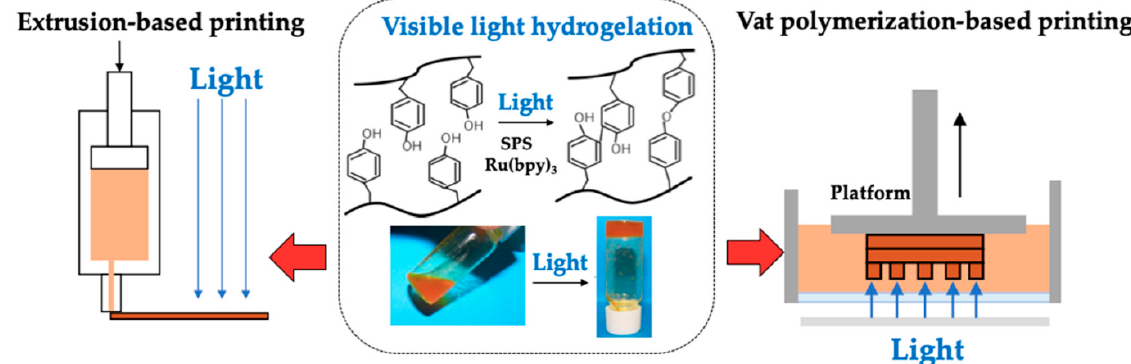
Figure 19. Schematic representation of the coating process using chitosan-based ink (taken from [47] under Creative Commons License).